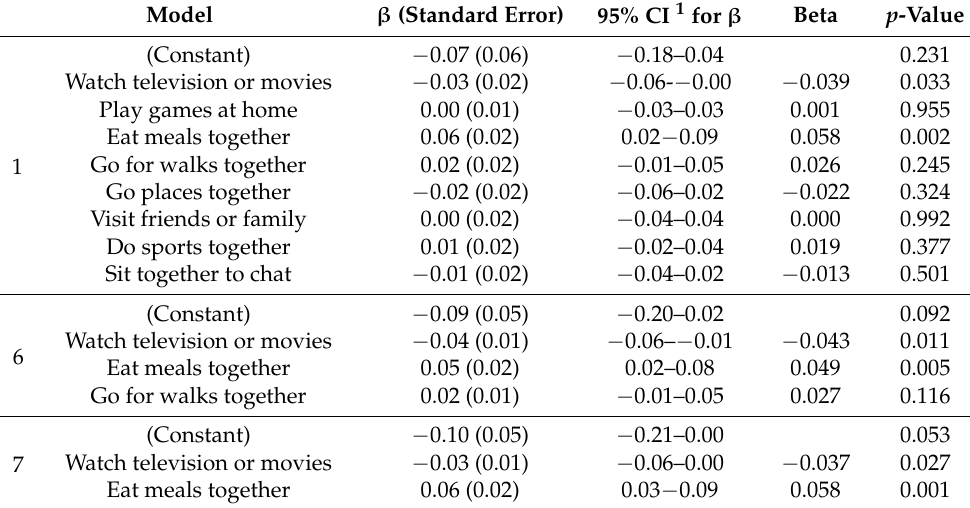
Table 3. Backward stepwise regression model activities with family that are associated with duration of active school